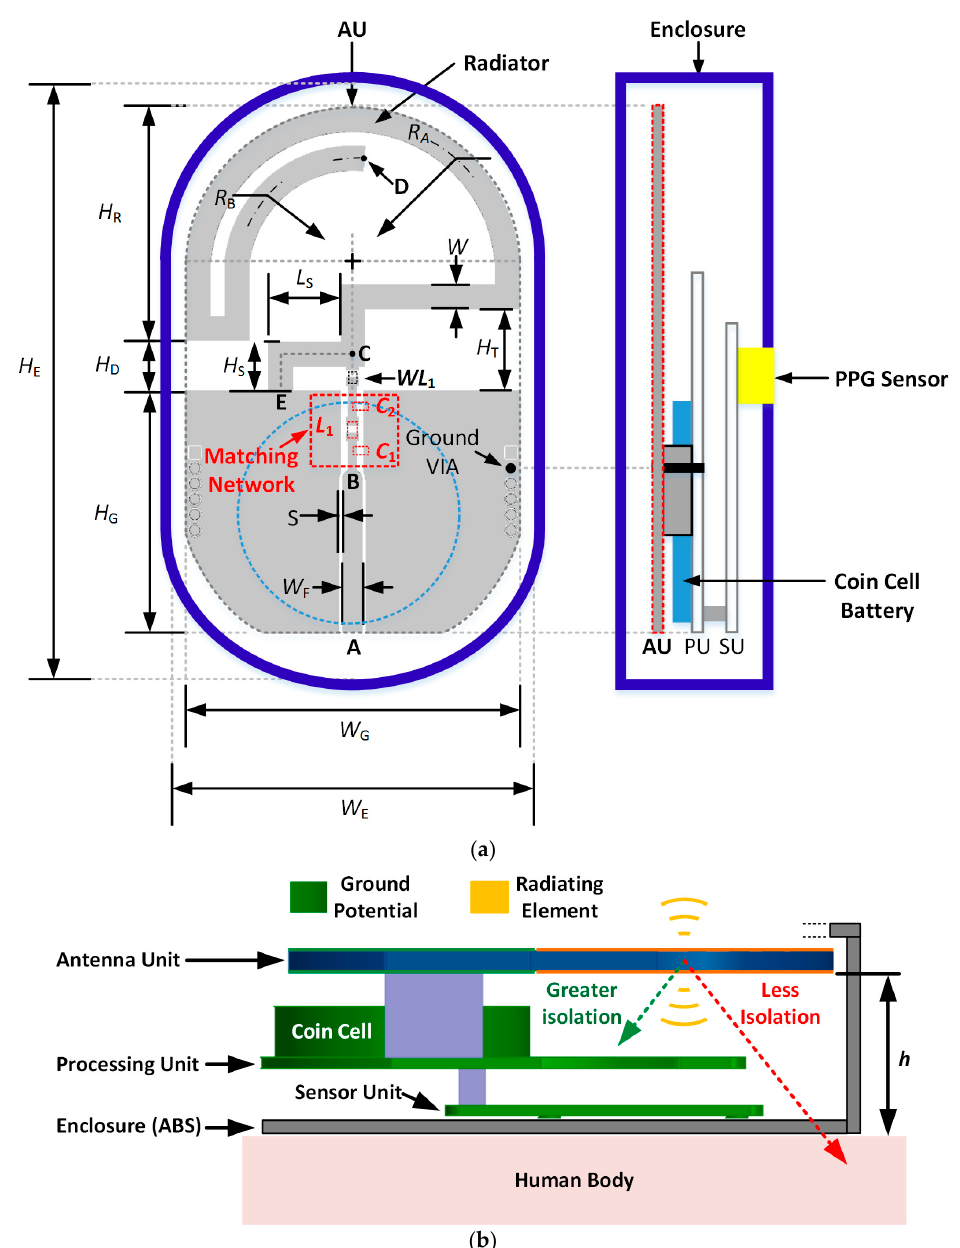
Figure 7. ( a ) Geometry of the proposed antenna: top view ( Left side) and side view cross-section ( Right side not to scale); ( b ) Improving antenna-body isolation.